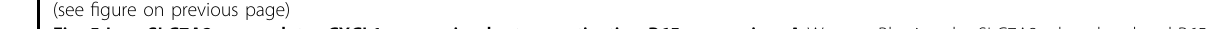
Fig. 5 Low SLC7A2 upregulates CXCL1 expression by transactivating P65 expression. A Western Blotting the SLC7A2, phosphorylated P65 at ser 536 (p-P65 Ser536 ), P65, P50, p-IKB α , IKB α , β -actin was used as control. B qRT-PCR was used to detect that relative mRNA expression of CXCL1 in the indicated cells with treatment with NF-k κ B inhibitor, JSH-23 (10 μ m, 24 h). The data are shown as the mean ± SD from the at least three independent experiments; * P < 0.05, ** P < 0.01. C ELISA was used to detect that relative expression of CXCL1 in the indicated cells with treatment with NF- κ B inhibitor, JSH-23 (10 μ m, 24 h). The data are shown as the mean ± SD from the at least three independent experiments; * P < 0.05, ** P < 0.01. D The expression of phosphorylated P65 was analyzed in the nuclear and cytoplasmic fractions of Huh7-shSLC7A2 cells and MHCC97H-SLC7A2 cells. The laminB1 and β -actin were as control respectively. E Luciferase reporter assay was showed in the indicated co-transfected with pCMV-SLC7A2 and the CXCL1 promoter-luciferase construct. The data are shown as the mean ± SD from the at least three independent experiments; ** P < 0.01. F Truncated and mutated CXCL1 promoter constructs were co-transfected with PCMV-SLC7A2, and the relative luciferase activity was con fi rmed. The data are shown as the mean ± SD from the at least three independent experiments; * P < 0.05. G ChIP assay con fi rmed the direct binding of P65 to the CXCL1 promoter in HCC cells. The data are shown as the mean ± SD from the at least three independent experiments; * P < 0.05. H ChIP assay con fi rmed the direct binding of P65 to the CXCL1 promoter in human HCC tissues. The data are shown as the mean ± SD from the at least three independent experiments; * P < 0.05. I Immuno fl uorescence of p-P65 Ser536 of indicated HCC cells. J Huh7-shSLC7A2 cells treated with inhibitors of PI3K, JNK, ERK, p38, STAT3, and then western blotting was used to detect the expression of SLC7A2 and p-P65 Ser536 in the nuclear as well as the total and phosphorylate expression of AKT, ERK, JNK, p38,